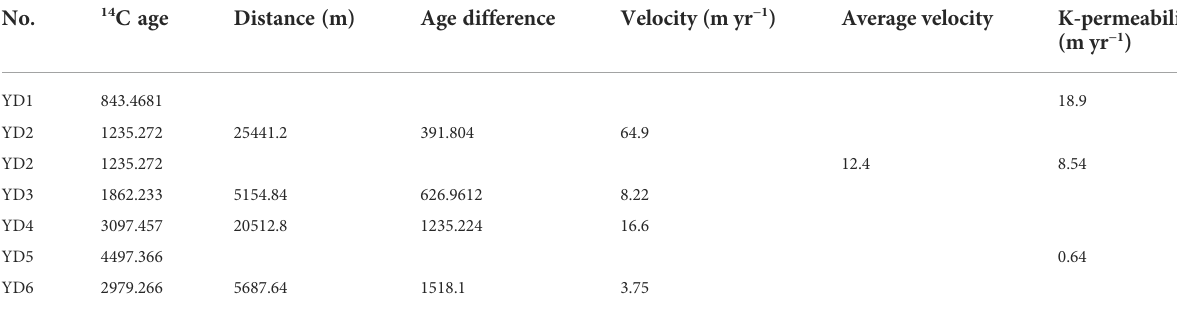
TABLE 5 14 C dating results in groundwater age.